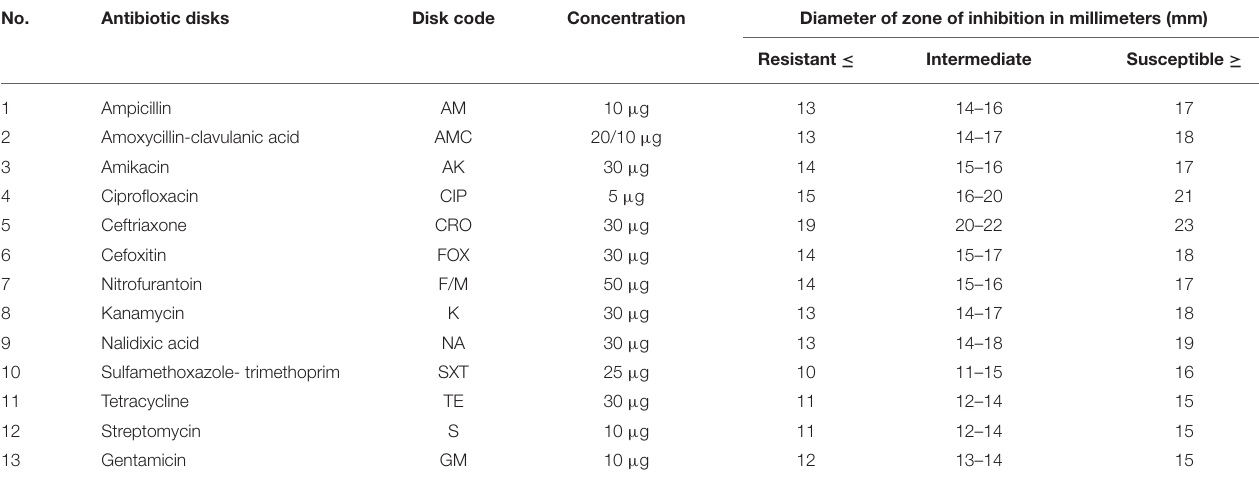
TABLE 2 | Prevalence of E. coli O157:H7 by risk factor. Risk factor